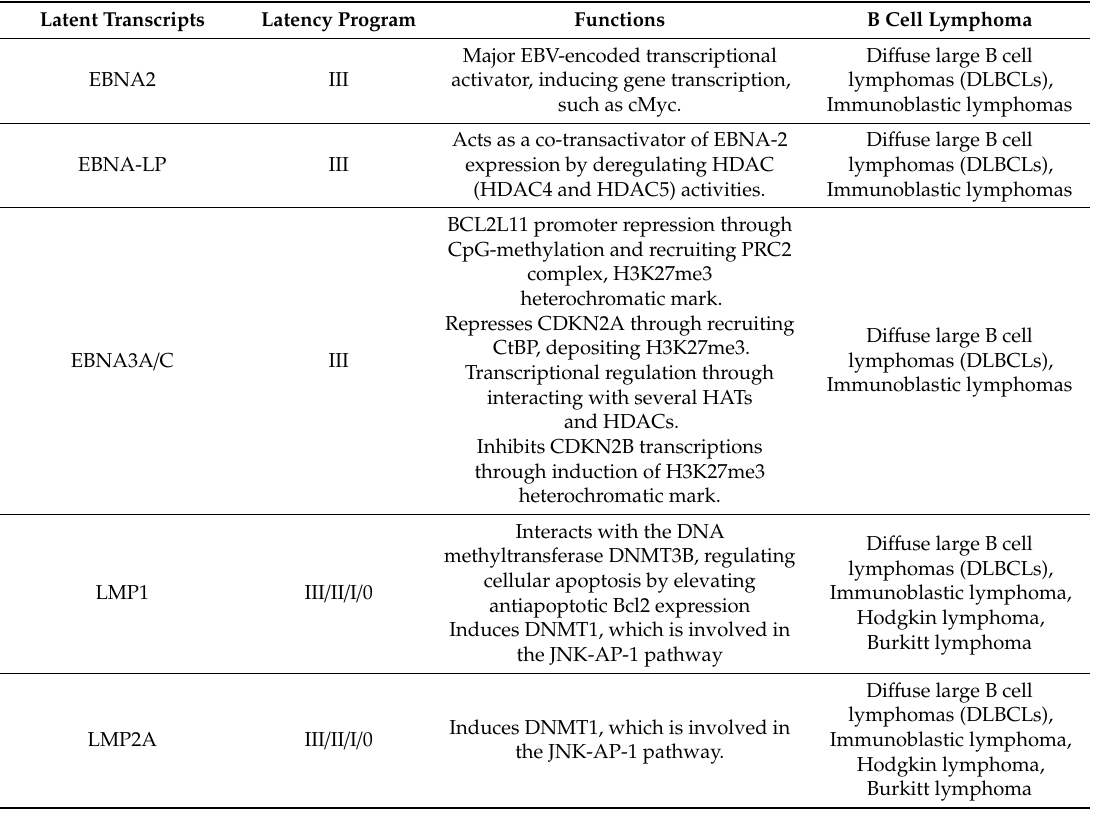
Table 1. Summary of EBV latent transcripts and their functions in epigenetic deregulation during B-cell